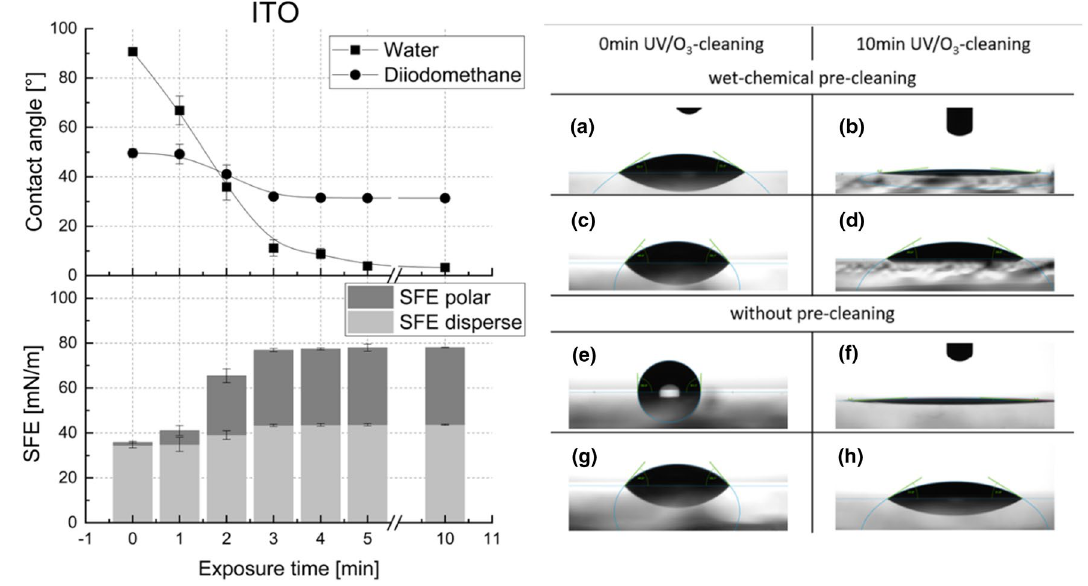
without UV/O Fig. 3 Left side: time-dependent change of the surface wettability -cleaning d contact angle of diiodomethane with 3 for water and diiodomethane and the corresponding surface free wet-chemical pre-cleaning and 10 min UV/O -cleaning, e contact 3 energies, whereby the total SFE is the sum of the polar and disper- angle of water without wet-chemical pre-cleaning and without sive fractions, for ITO without pre-cleaning; right hand side: picture of the contact angles. a contact angle of water with wet-chemical pre-cleaning and without UV/O -cleaning, b contact angle of water 3 with wet-chemical pre-cleaning and 10 min UV/O -cleaning, c con- 3 tact angle of diiodomethane with wet-chemical pre-cleaning and